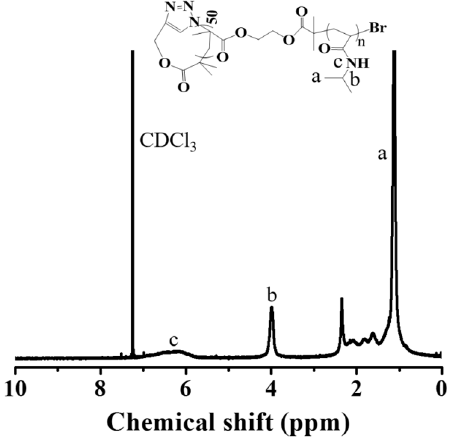
Figure 4. 1 H NMR spectrum of cb -P(HEMA- g -PNIPAAm) 50 in CDCl 3 .